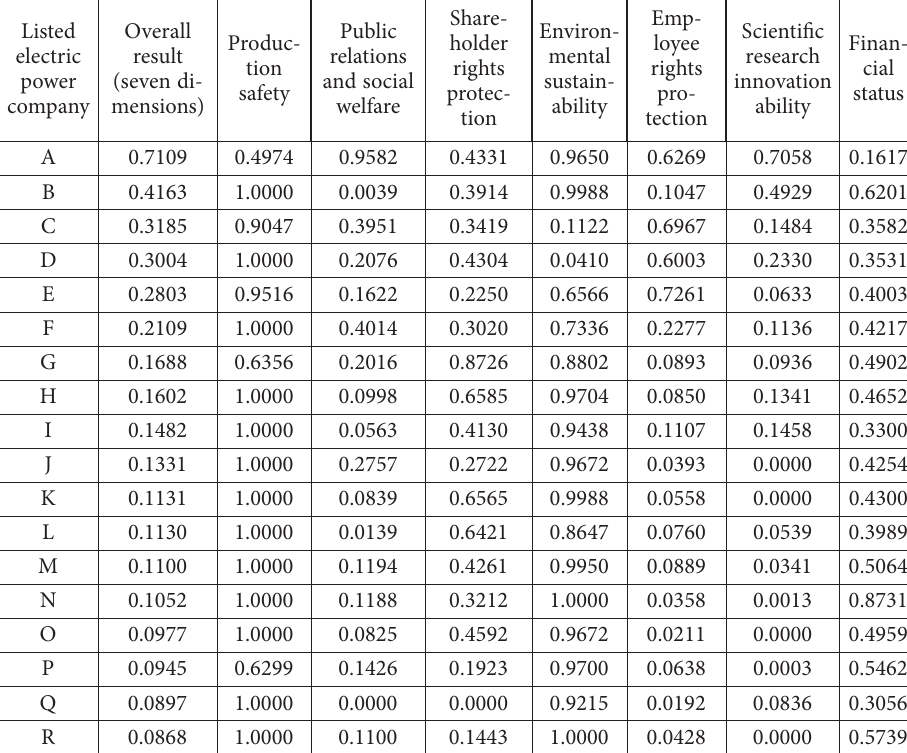
Table 3. Evaluations of sustainable development capacities of 18 listed electric power